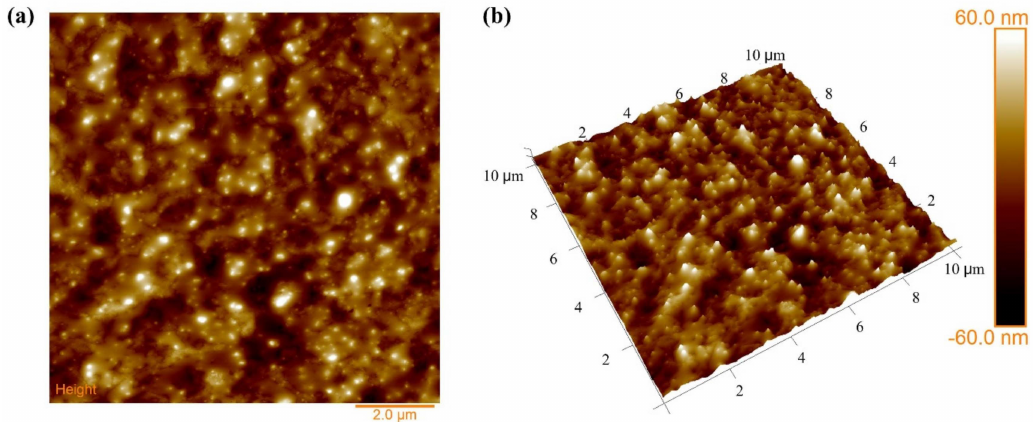
Figure 3. Atomic force microscopy (AFM) image of semi-conductive composites. ( a ) Two-dimensional distribution; ( b ) three-dimensional